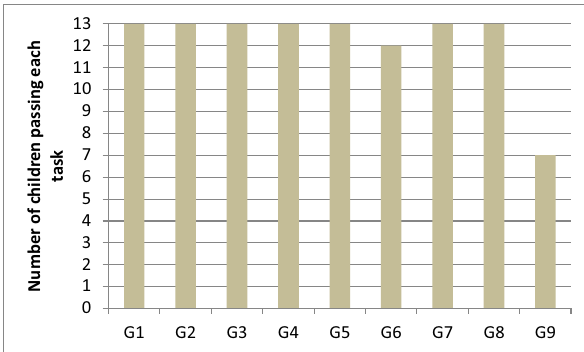
Figure 10: Success rates in each game.